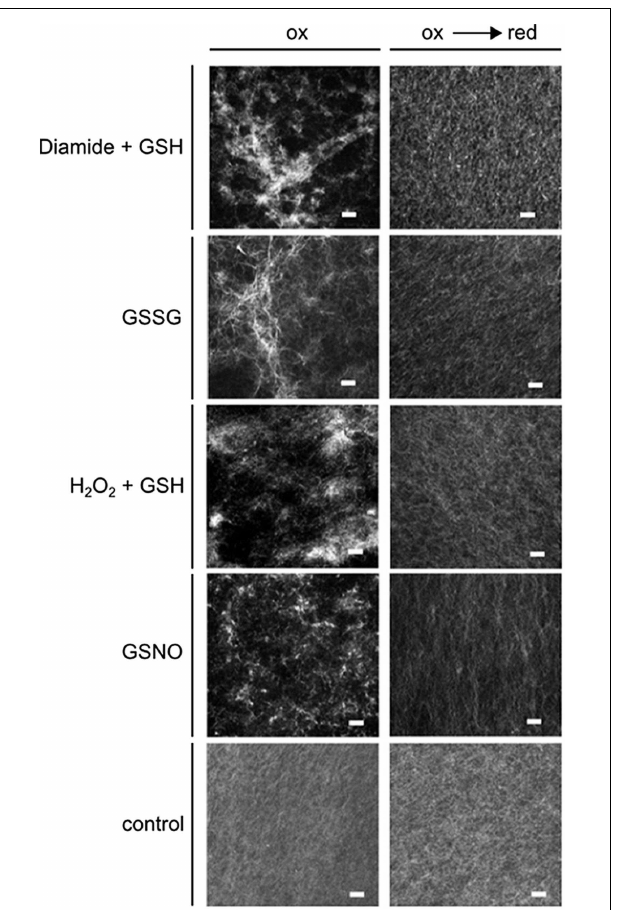
FIGURE 6 | Effect of redox-state on F-actin bundling activity of GapC and aldolase. Samples with rabbit F-actin, aldolase, and GapC1 were first oxidized with the specific redox reagents: diamide + GSH (each 0.5mM); GSSG (5mM); H 2 O 2 + GSH (each 0.5mM); GSNO (0.5mM) followed by a reduction step with DTT red (10mM). Subsequently, the samples were stained with rhodamine-labeled phalloidin (70nM) and fluorescence was visualized by cLSM.The control experiment represents an incubation of F-actin with BSA incubated with diamide + GSH, and the subsequent reduction with DTT. Scale bar: 10 µ